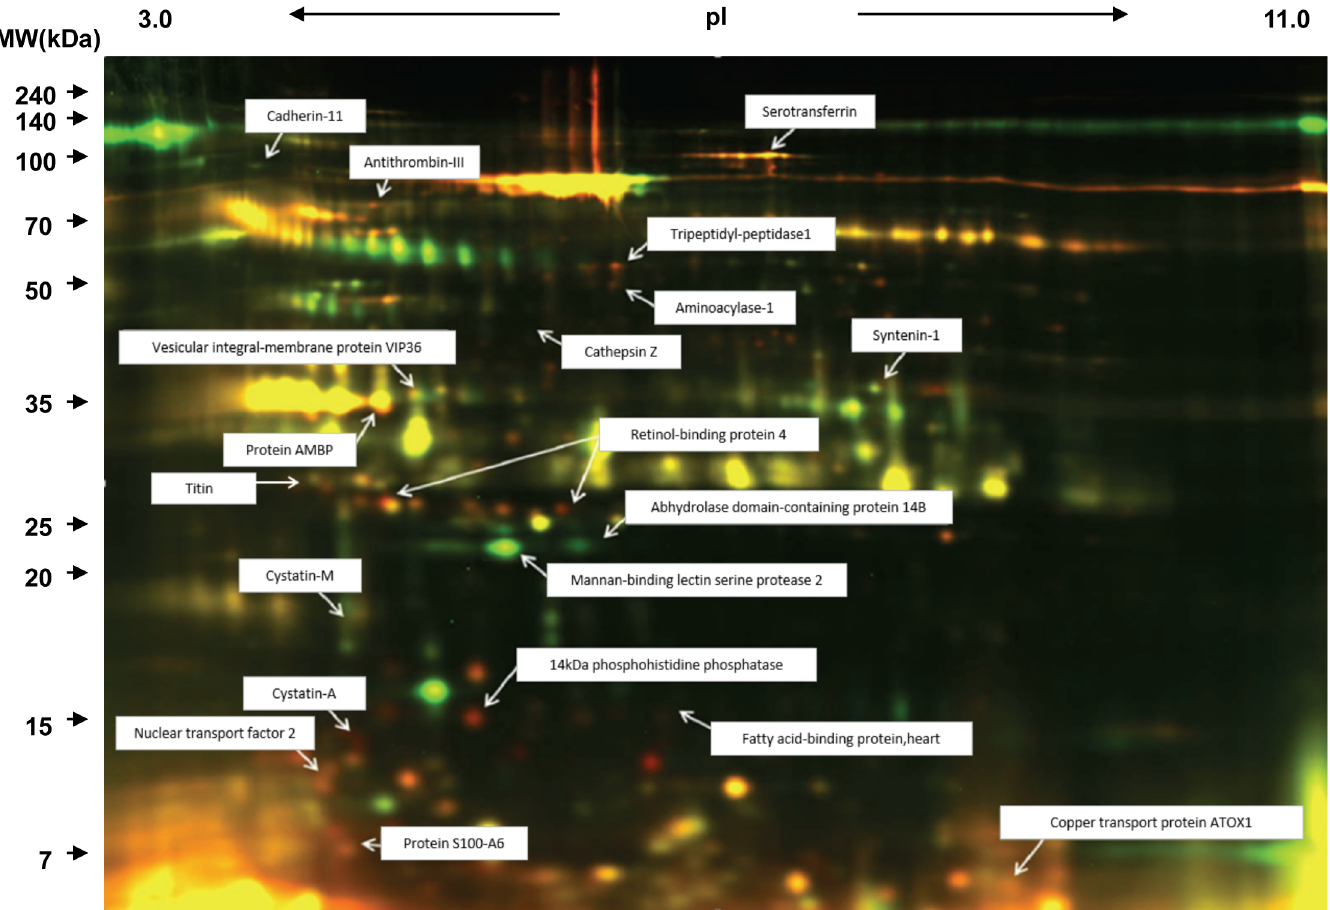
Fig 1. Typical 2D-DIGE images before and after eccentricexercise. Urine samples were labeledwith Cy3 (before) or Cy5 (immediately after). Red spots reflect increasedprotein expressionafter exercise.